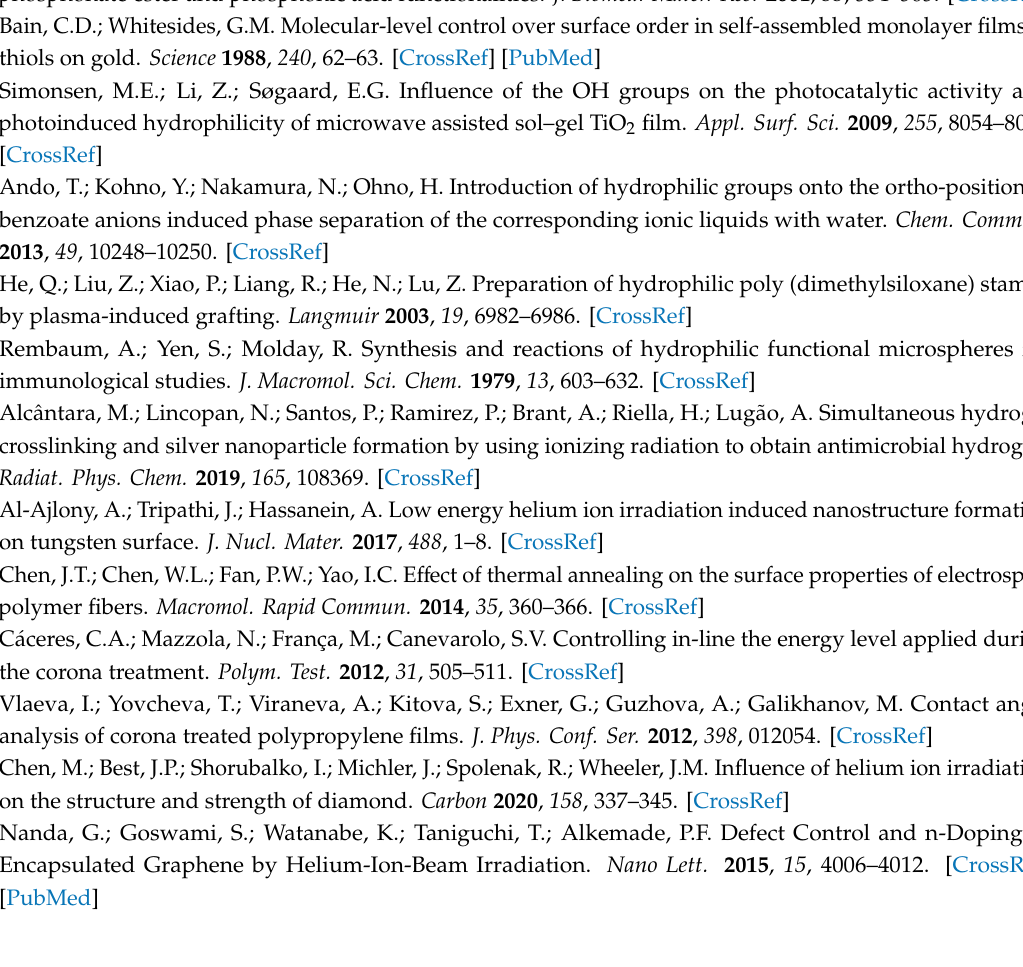
Figure S1: Measured gamma spectrum of a polymer irradiated with a 20 MeV helium ion